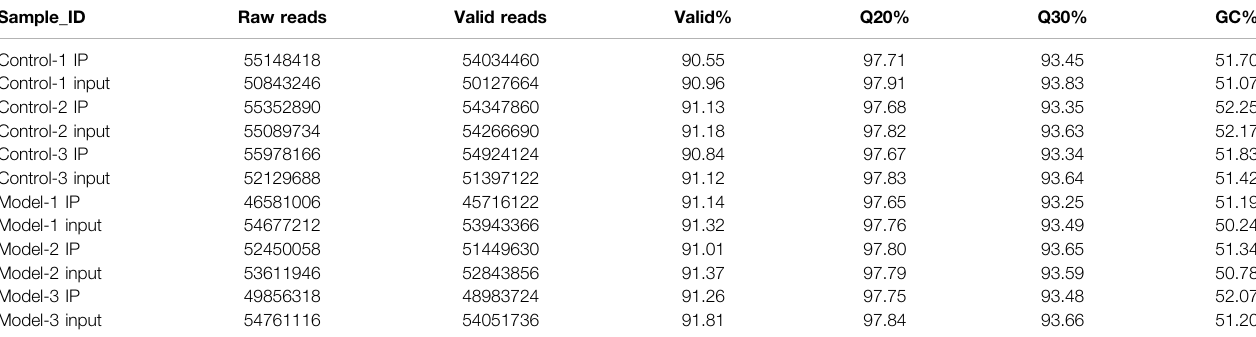
TABLE 3 | Sequencing reads and alignment statistics in placental of control and model rats. Sample_ID